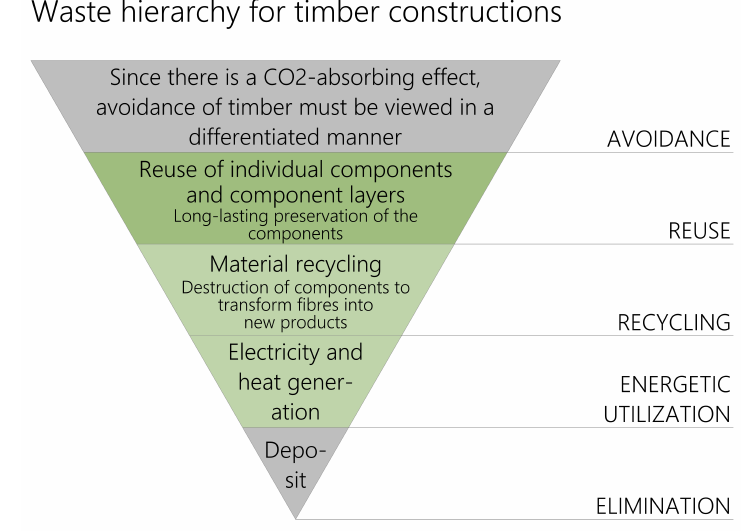
Figure 4. Timber waste hierarchy